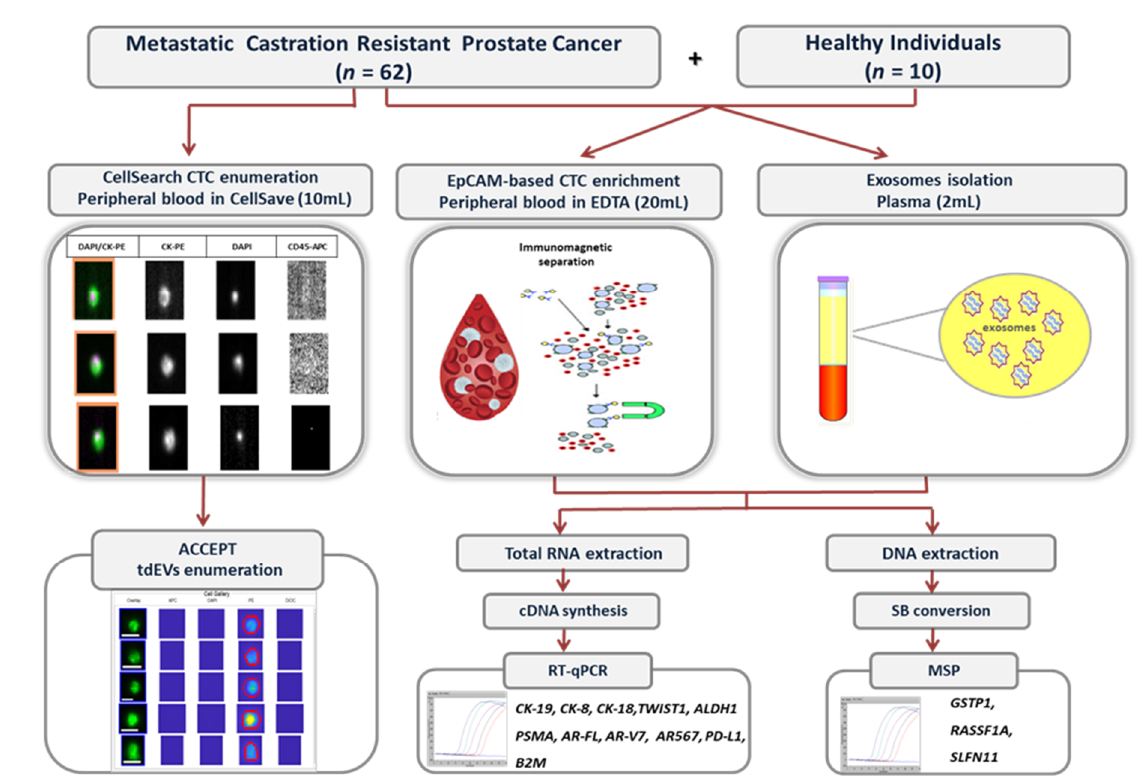
Figure 1. Experimental flowchart of the study .